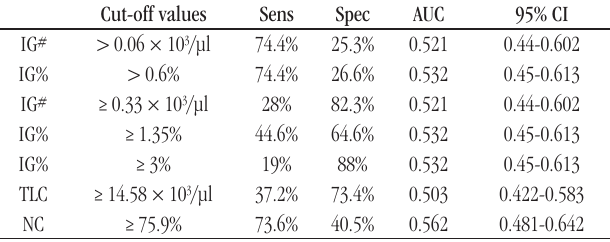
taBLE 4 − Characteristics of the diagnostic test when comparing IG# and IG% values in positive and negative cultures Cut-off values